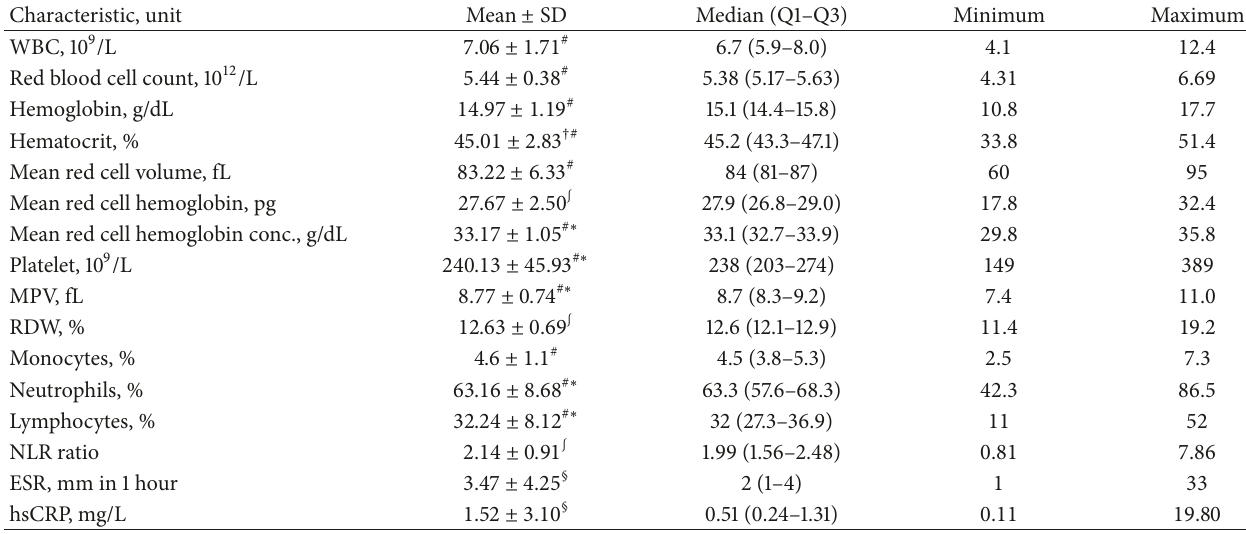
Table 2: Hematological characteristics of the participants (𝑛 = 101) ; the results are presented as mean ± standard deviation (SD), median, first and third quartiles (Q1–Q3), minimum, and maximum. Damascus, Syria, April 2016. Characteristic, unit